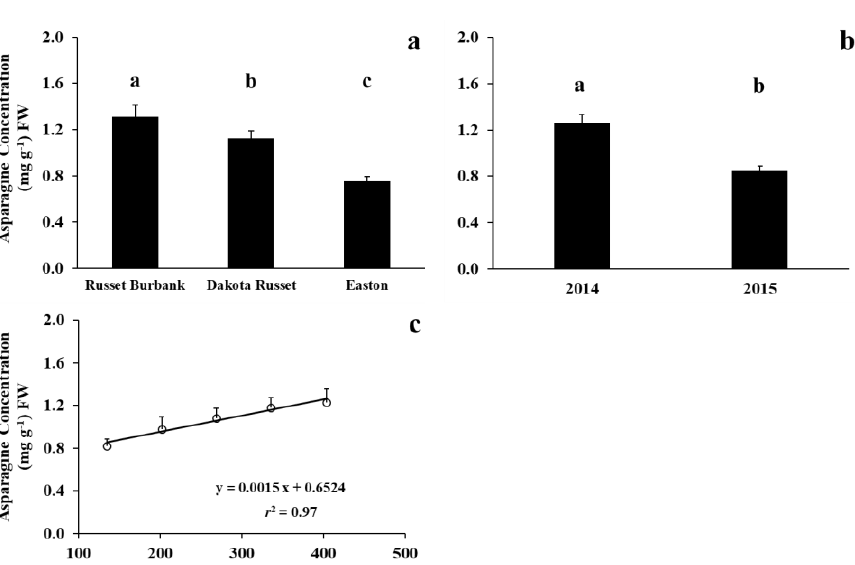
Figure 5. Cultivar by year interaction effect on acrylamide concentration at 16-week storage (Means were separated at the 5% level, with the same letter above the bar indicating no significant difference.).